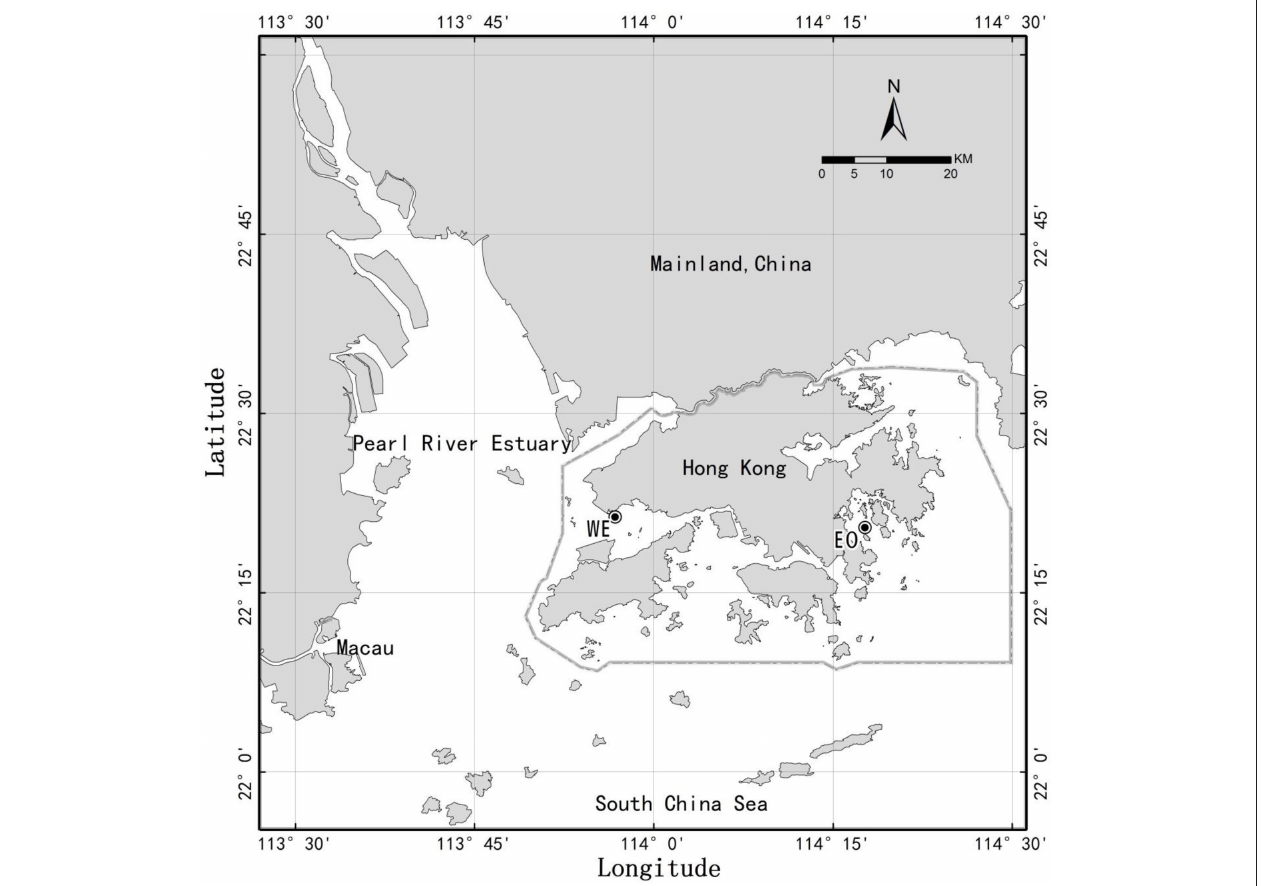
FIGURE 1 | Map of Hong Kong waters showing two stations, WE in western estuarine waters and EO in eastern coastal water. Circle around Hong Kong indicate the Special Administrative Regions of